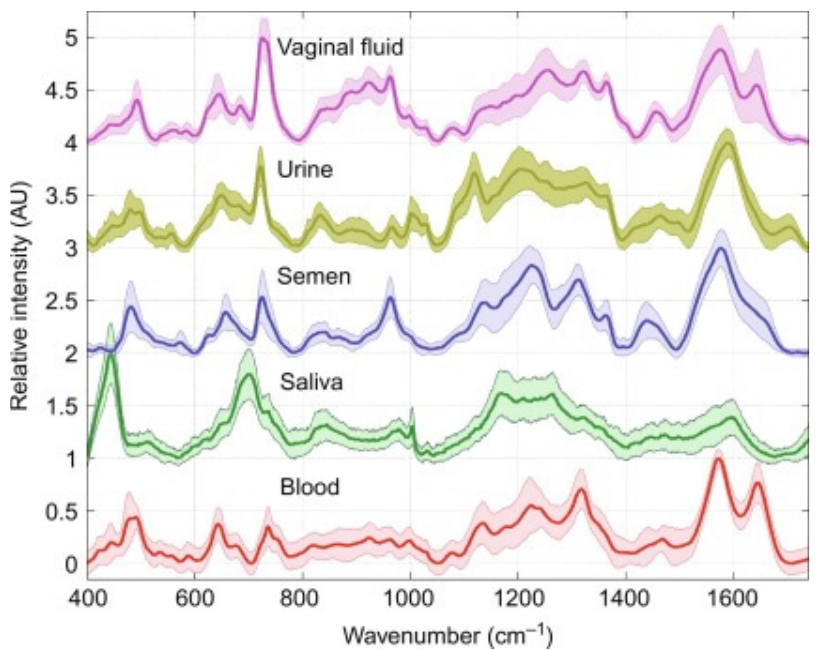
Figure 1. SERS spectra of dried human body fluids. Shaded regions correspond to standard deviation of 60 spectra (two donors of each body fluid type). Picture reproduced with permission from “ Frontiers and Advances in Molecular Spectroscopy ”, Jaan Laane, Elsevier, 2018 [36].